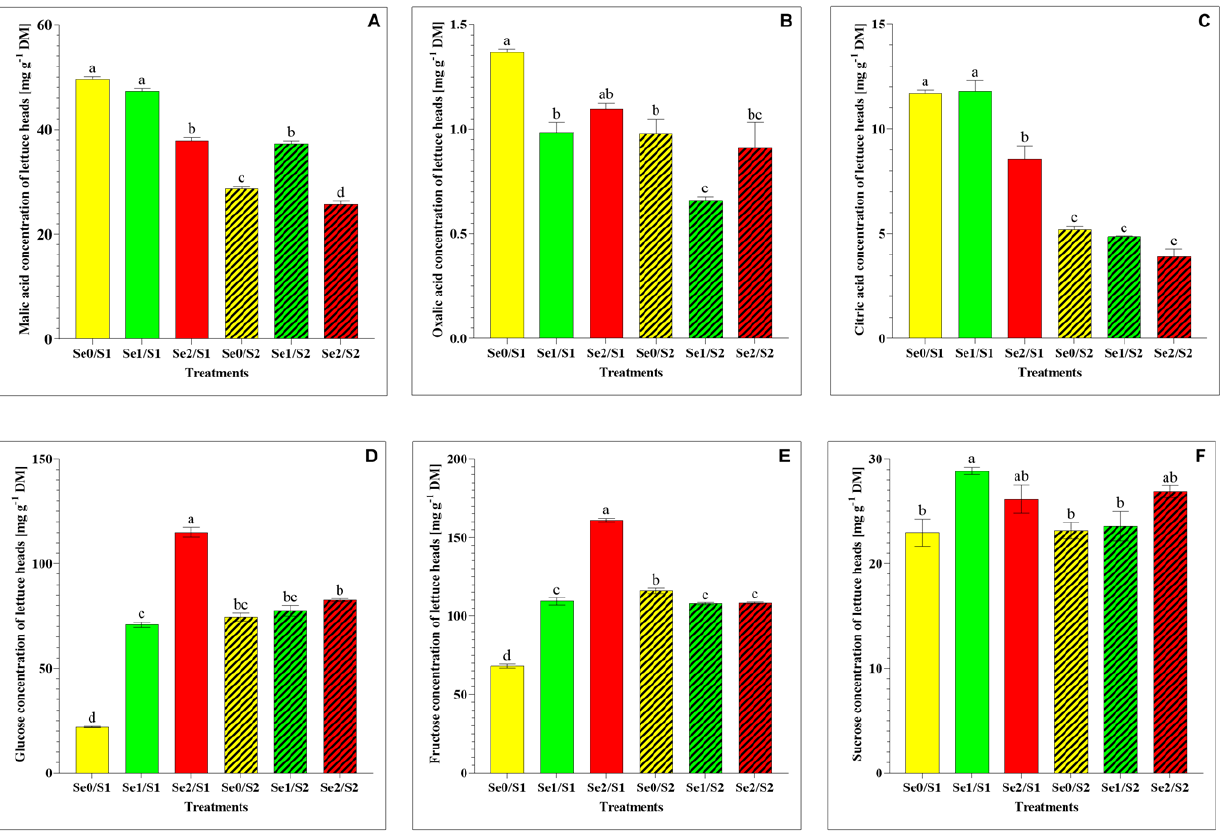
Figure 4. ( A ) malic acid; ( B ) oxalic acid; ( C ) citric acid; ( D ) glucose; ( E ) fructose; and ( F ) sucrose accumulation in the lettuce plants grown in a hydroponic system and treated with two S levels (S1: 1 mM; and S2: 2 mM (K 2 SO 4 )), and three Se levels (Se0: 0 µM; Se1: 1.3 µM; and Se2: 3.8 µM (Na 2 SeO 4 )). The data presented are the means ± SE of four replicates. Different letters show statistically significant differences among all the treatments ( p ≤ 0.05; Tukey’s test).